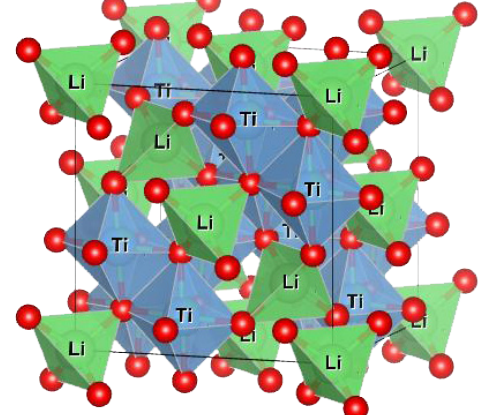
Fig. 2. The unit cells of the LTO, where the green tetrahedrons, blue octahedrons and red spheres represent Li ions at the 8a site, Li and Ti ions at the 16d site, and O ions at the 32e site, respectively.